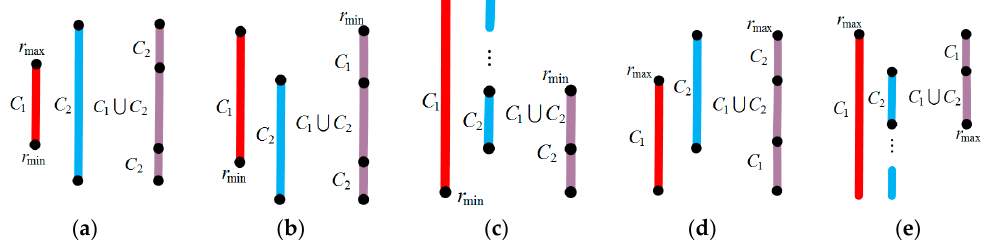
Figure 7. Five conditions of splitting intervals: ( a ) the maximum and minimum values of an interval are within another interval; ( b ) the minimum value of an interval is within another interval; ( c ) the minimum value of an interval is outside all the intervals of another interval set; ( d ) the maximum value of an interval is within another interval; and ( e ) the maximum value of an interval is outside all the intervals of another interval set.